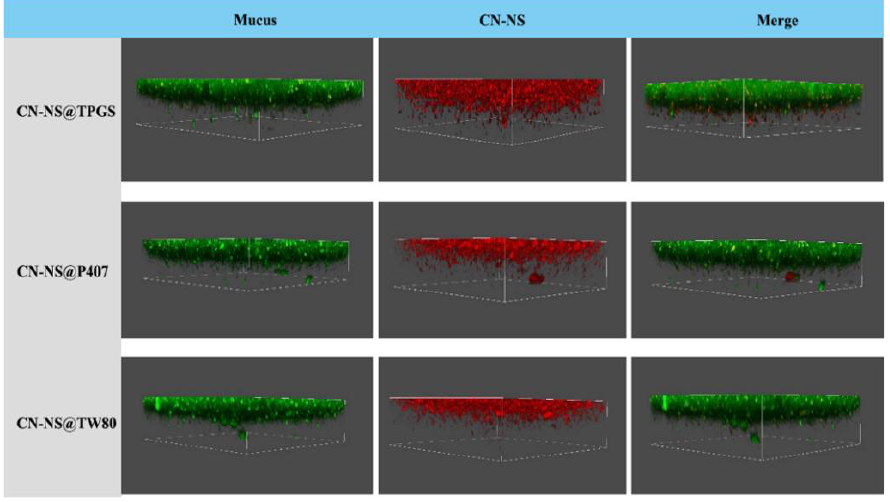
Figure 5. Three-dimensional imaging of the distribution of CN-NSs in mucus.